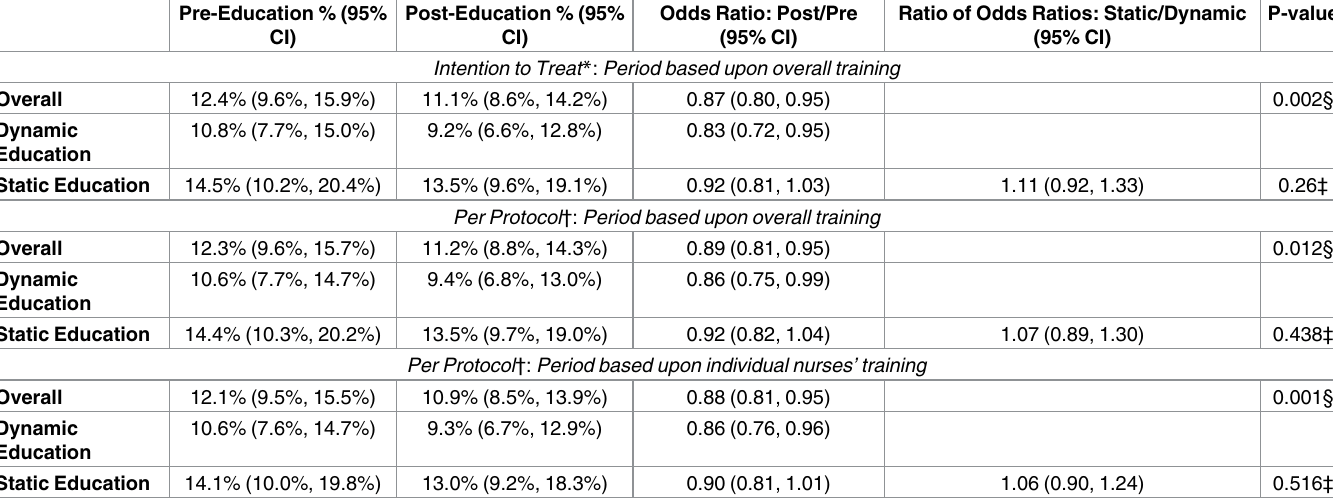
Table 2. Comparison of the pattern of non-administration of prescribed venous thromboembolism prophylaxis medication doses for the dynamic and static education interventions. The pre- and post-education periodsare definedeither based upon the overall trainingperiod(i.e. excludingall visits within the trainingperiodregardlessof the individualnurses’ trainingwith a common pre- and post- period) or basedupon the individualnurses’training(i.e. includesall visits within the pre- and post- periodfor each individualnurse).